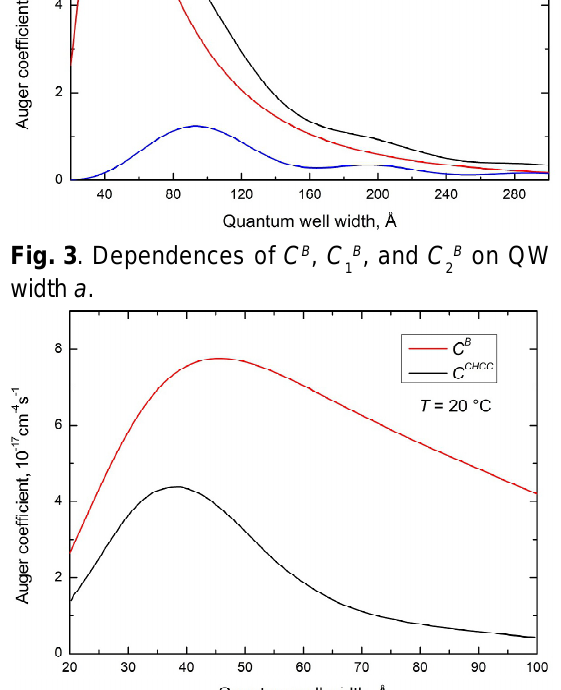
Fig. 4. Dependences of C CHCC and C B on QW width